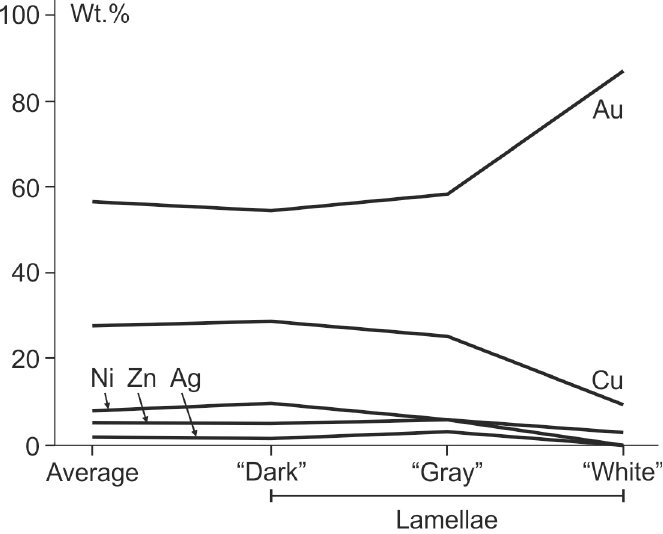
Figure 14. Compositional variations in various lamellae and their host Cu-Ag-Au-Ni-Zn spherules. 5.5. Gold in Pyroclastic Rocks from the Kaylan